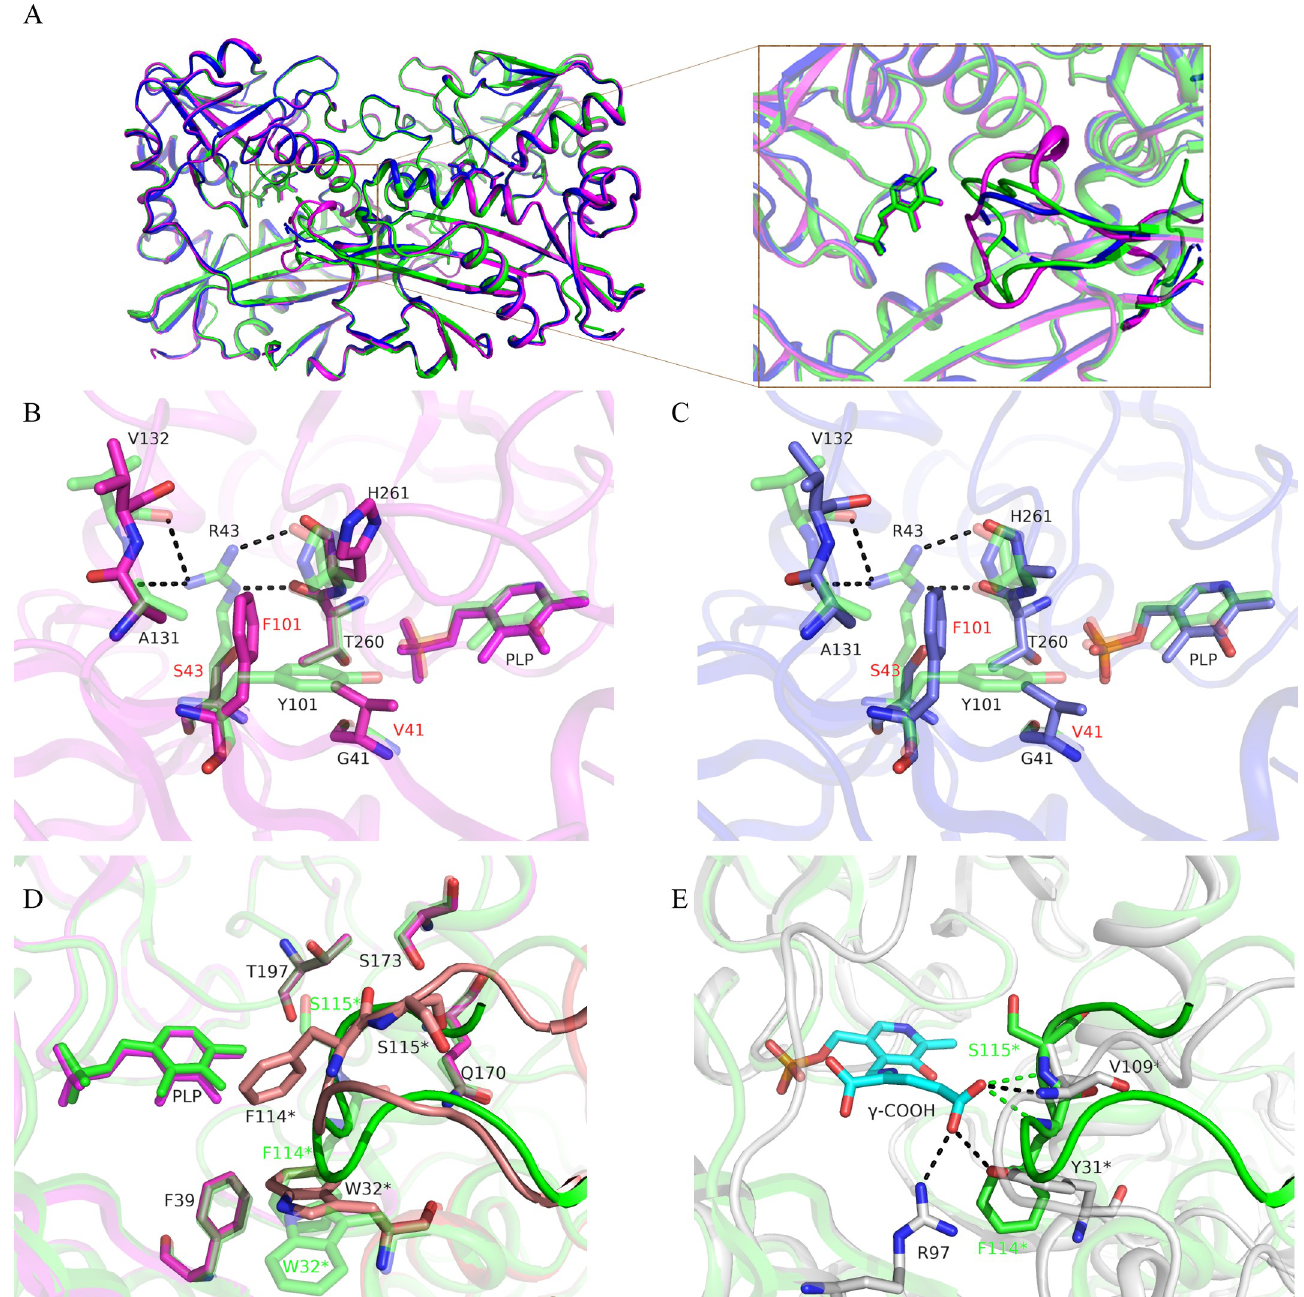
Fig 3. Structural comparison of WT TaTT and its variants. (A) Superposition of WT TaTT (green), mP3 (magenta) and mP3O1 (blue) dimers. PLP molecules are shown as sticks. Insert is a zoomed view on a region of the O-pocket loop with the major changes between the structures (the other part of molecules are shown transparently for clarity). (B) Active center superposition between WT TaTT (green, transparent) and mP3 (pink). Hydrogen bonds are shown as dashed lines. Mutated in mP3 residues are labeled in red. (C) Active center superposition between WT TaTT (green, transparent) and mP3O1 (blue). Label coding is similar to panel B. (D) Comparison of the O-pocket loop regions in WT TaTT (green) and mP3 (pink). O-pocket loop in mP3 is colored in coral. The rest of the molecules are transparent. Important O-pocket loop residues of the WT TaTT are labeled in green. Residues from another subunit of the dimer are marked with an asterisk. (E) Comparison of α -ketoglutarate γ -COOH group binding in E . coli BCAT (white, PDB ID 1IYE) and WT TaTT (green). α -ketoglutarate covalently bound to PLP molecule is shown with cyan. Corresponding hydrogen bonds are shown as dashed lines.